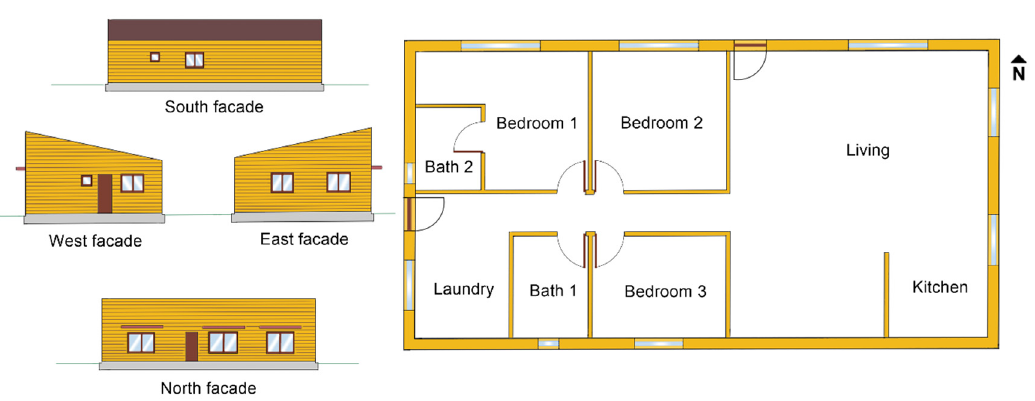
Figure 2. The architectural design of the house. Note: For data entry into PHPP, the cardinal direction “North” was changed by 180°. This is the recommended approach for buildings in the Southern hemisphere as per the PHPP User’s Manual.